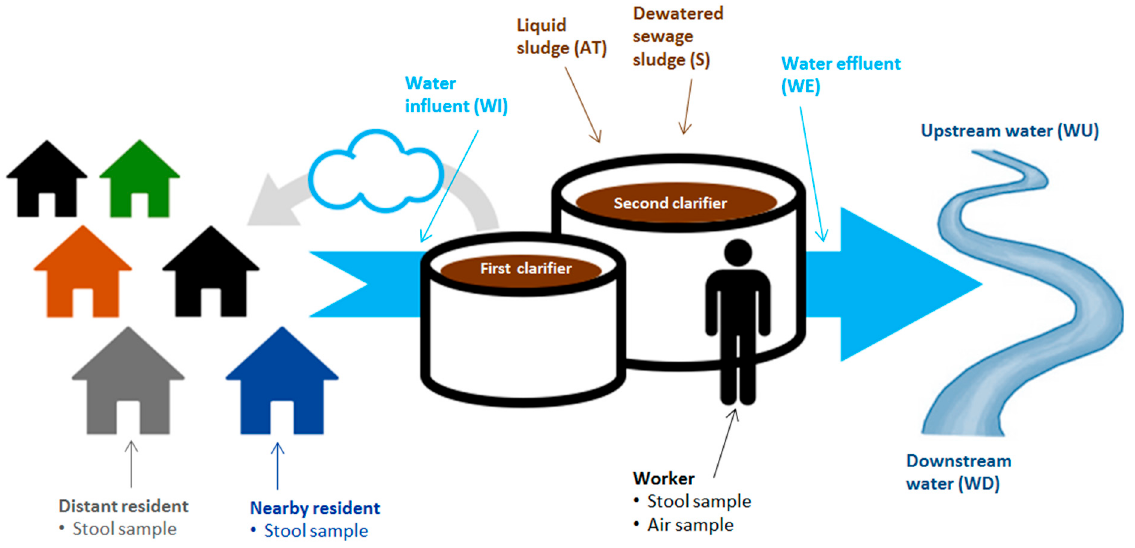
Figure 2. Collection points of water, air, and stool samples.